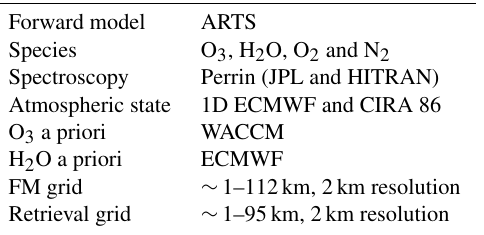
Table 2. Main parameters used in GROMOS and SOMORA re-